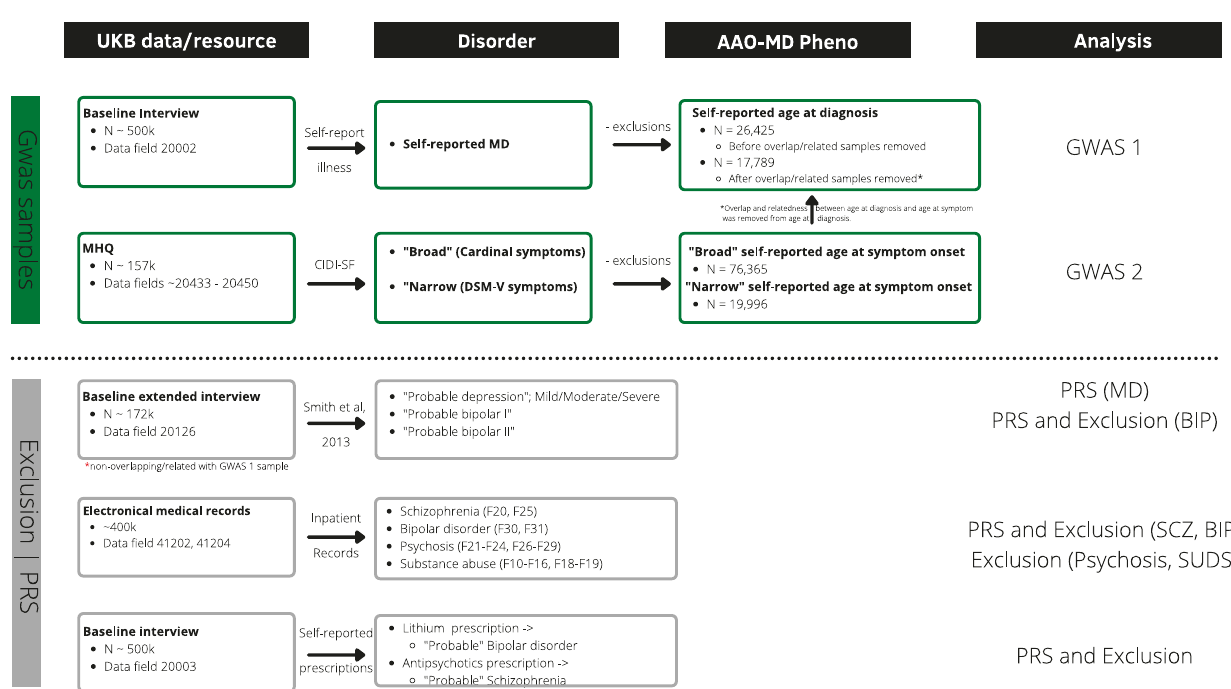
Fig. 1 Phenotypic de fi nitions in UK Biobank. This fi gure displays the data sources used for each de fi nition, and for what purpose the de fi nition was derived. The two MD de fi nitions are marked with green box color. Data sources and de fi nitions for the exclusion criteria, self- reported lithium/antipsychotics prescriptions, probable depression, and probable bipolar disorder type I and II are marked with gray box